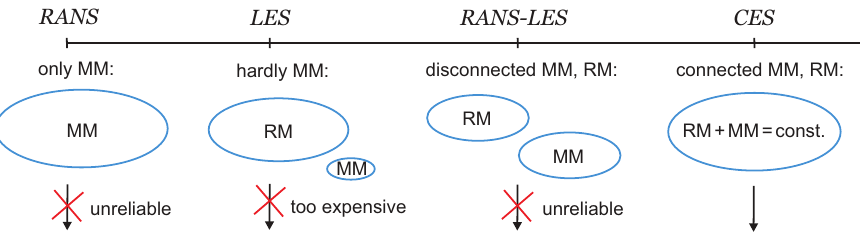
Figure 1. Abilities of computational methods in regard to reliable and feasible predictions of high Re flows that require flow resolution. Here, hybrid RANS-LES refers to popular methods, MM (RM) refers to modeled (resolved) motion, and CES refers to continuous eddy simulation.